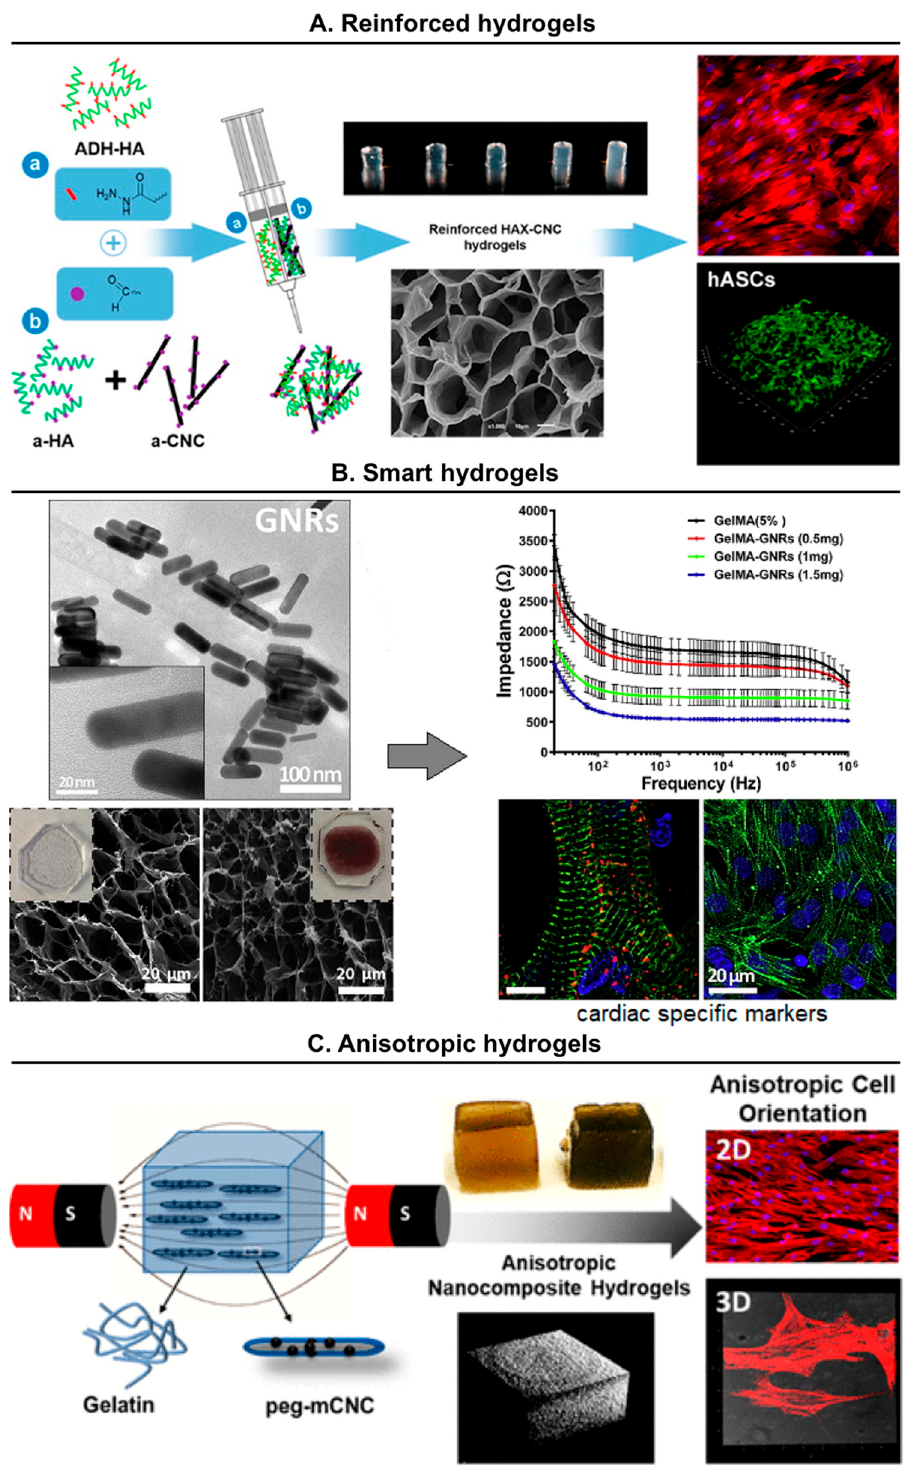
Figure 6. Examples of advanced nanocomposite hydrogels showing reinforced, smart or anisotropic characteristics. ( A ) Injectable hyaluronic acid (HA) hydrogels mechanically reinforced with cellulose nanocrystals (CNC). Reproduced with permission from [149], copyright 2015, American Chemical Society; ( B ) gelatin-based hydrogels with high electrical conductivity due to the incorporation of gold nanorods (GNRs). Adapted with permission from [166], copyright 2016, Elsevier; ( C ) anisotropic gelatin hydrogels produced by the magnetic alignment of magnetic-responsive particles (peg-mCNC). Reproduced with permission from [176], copyright 2019, American Chemical Society.